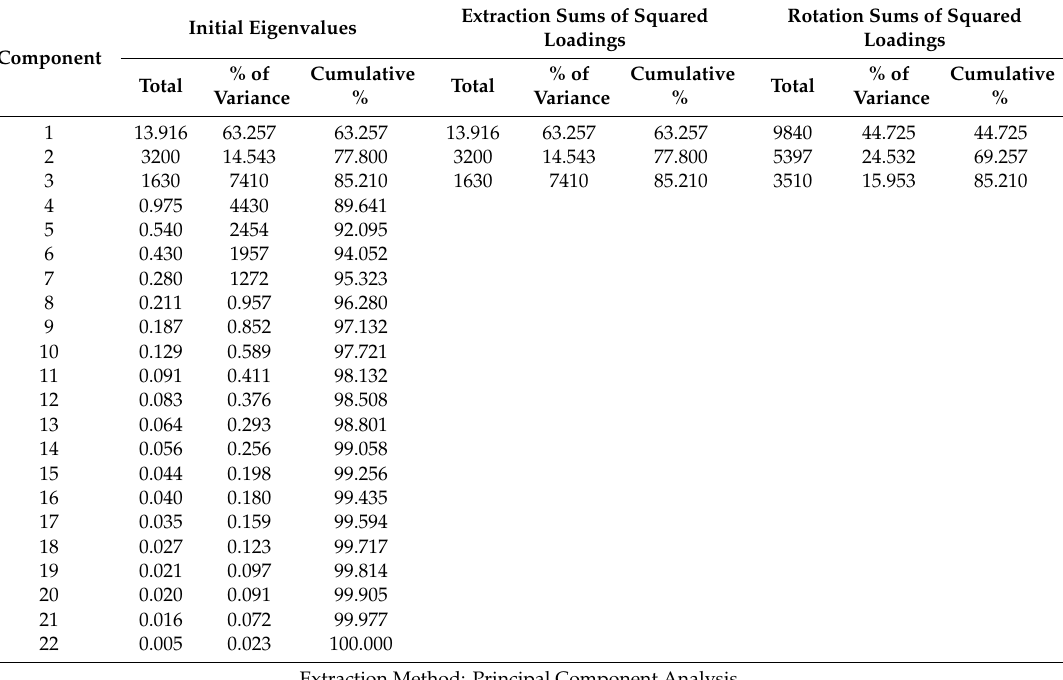
Figure 3. Component plot in rotated space (source: own processing (SPSS)). Table 2. Total variance explained.